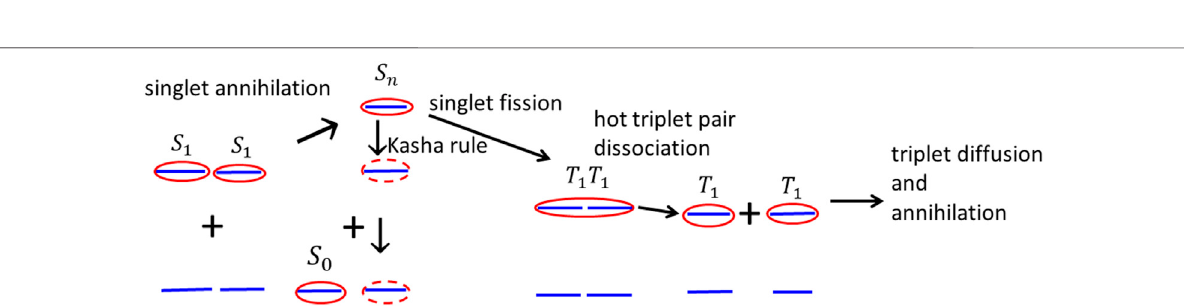
Frontiers in Chemistry |